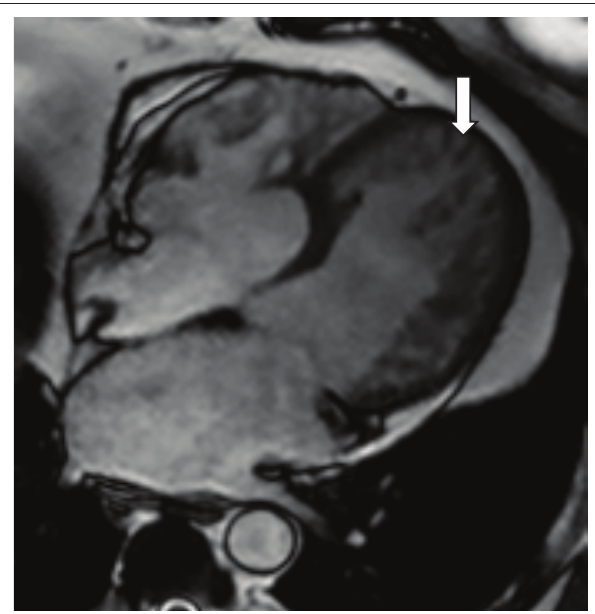
FIGURE 3: Left ventricular noncompaction. Four-chamber cine b-SSFP demonstrating increased LV trabeculations (arrow) at the LV free wall and apex compared with the compact LV myocardium. The RV trabeculations are prominent